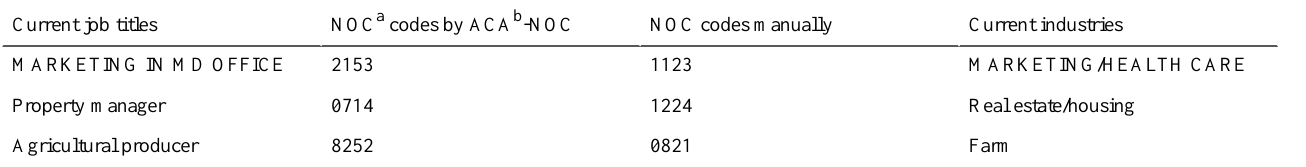
Table 6. Unmatched data for Generation 1.